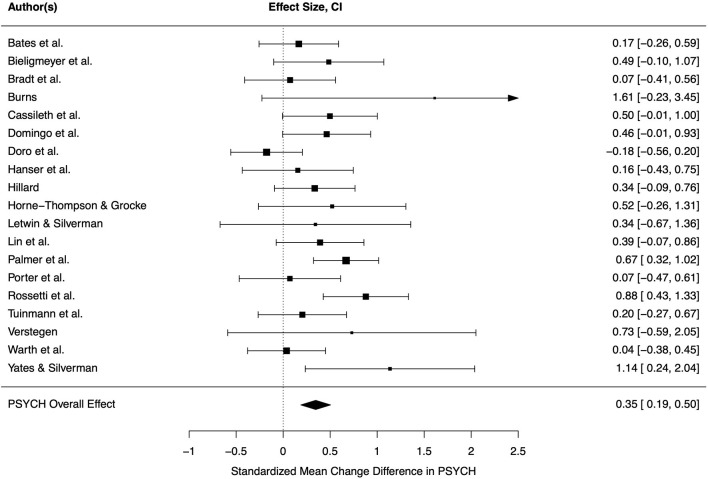
Forest plot for psychological well-being. CI, 95% confidence interval, PSYCH, psychological well-being.